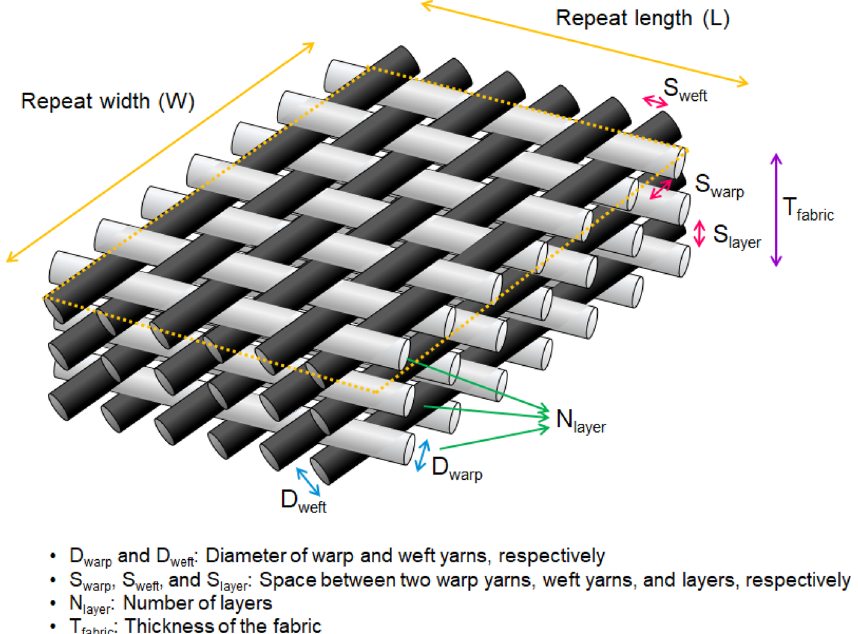
Figure 3. Three-dimensional structural parameters of single- and multi-layered woven